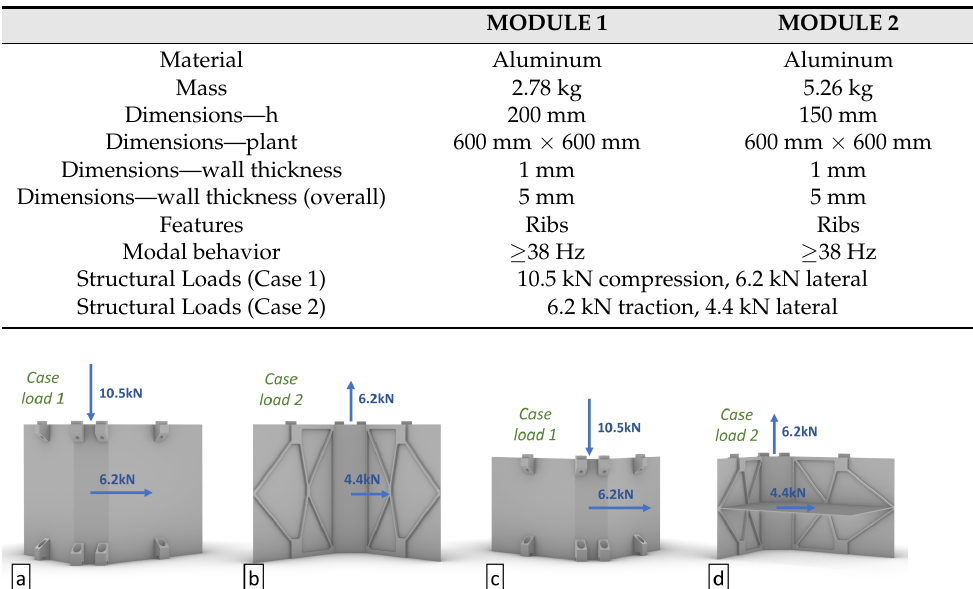
Table 3. Original design specification and structural loads.